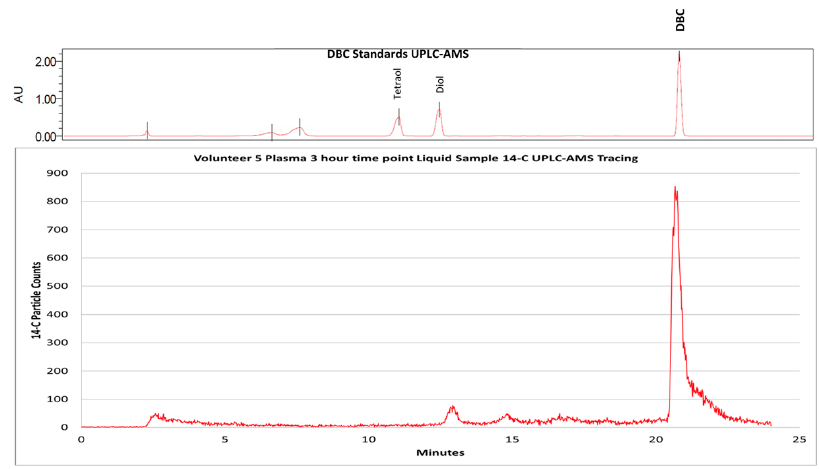
Figure 1. UHPLC-AMS of [ 14 C]-DBC and putative metabolites from human plasma 3 h after and oral dose of 29 ng 14 C-DBC. The use of unlabeled parent DBC and standards (DBC-(±)-11,12-diol and DBC- (±)-11,12,13,14-tetraol) (top graph) allow for the identification of 14 C peaks in plasma (bottom graph).